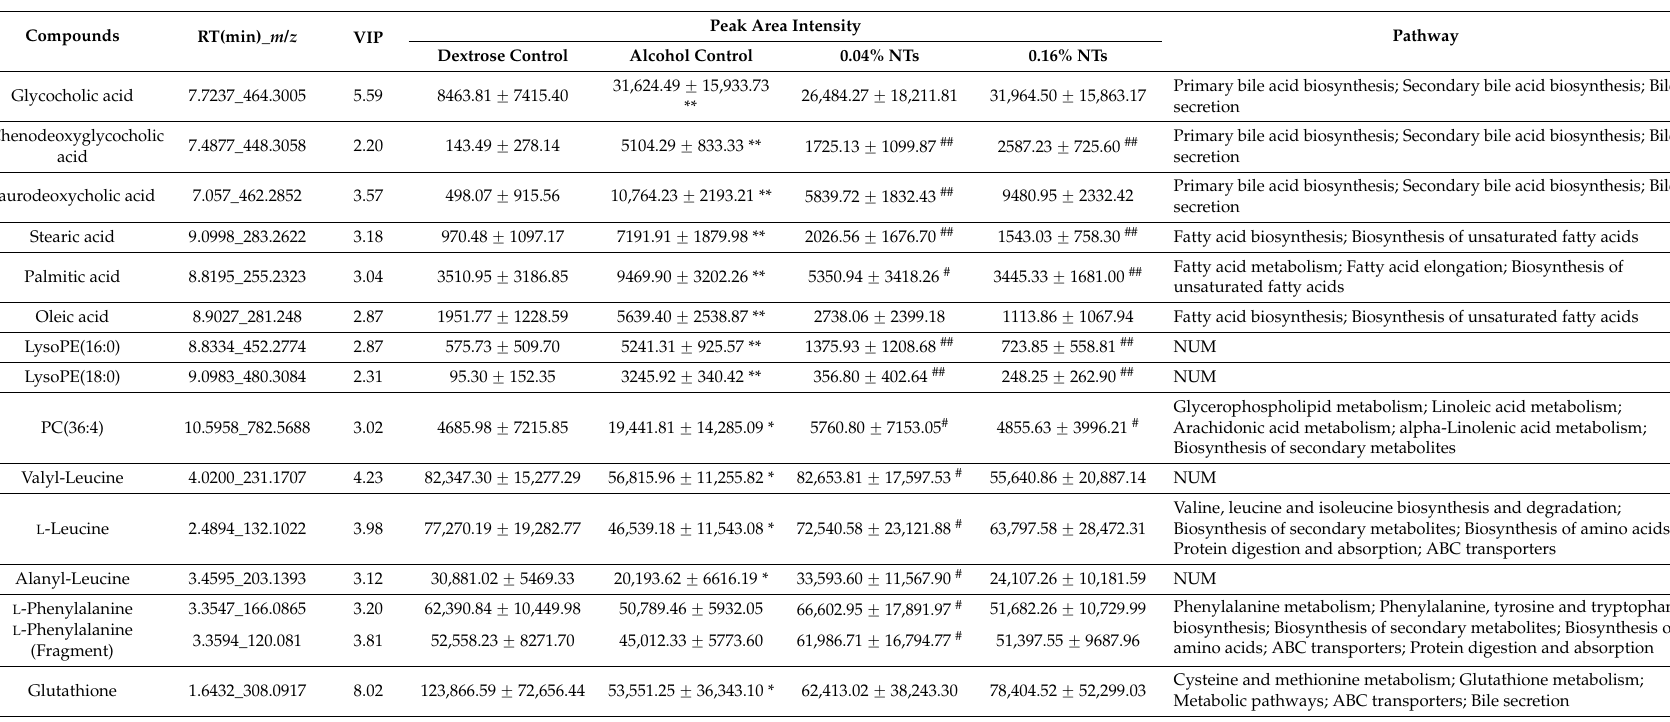
Table 2. Representative differential metabolites of liver that contributed to the separation among dextrose-, alcohol- and NTs-treated rats derived from UPLC-TOF-MS analysis (n 6 per